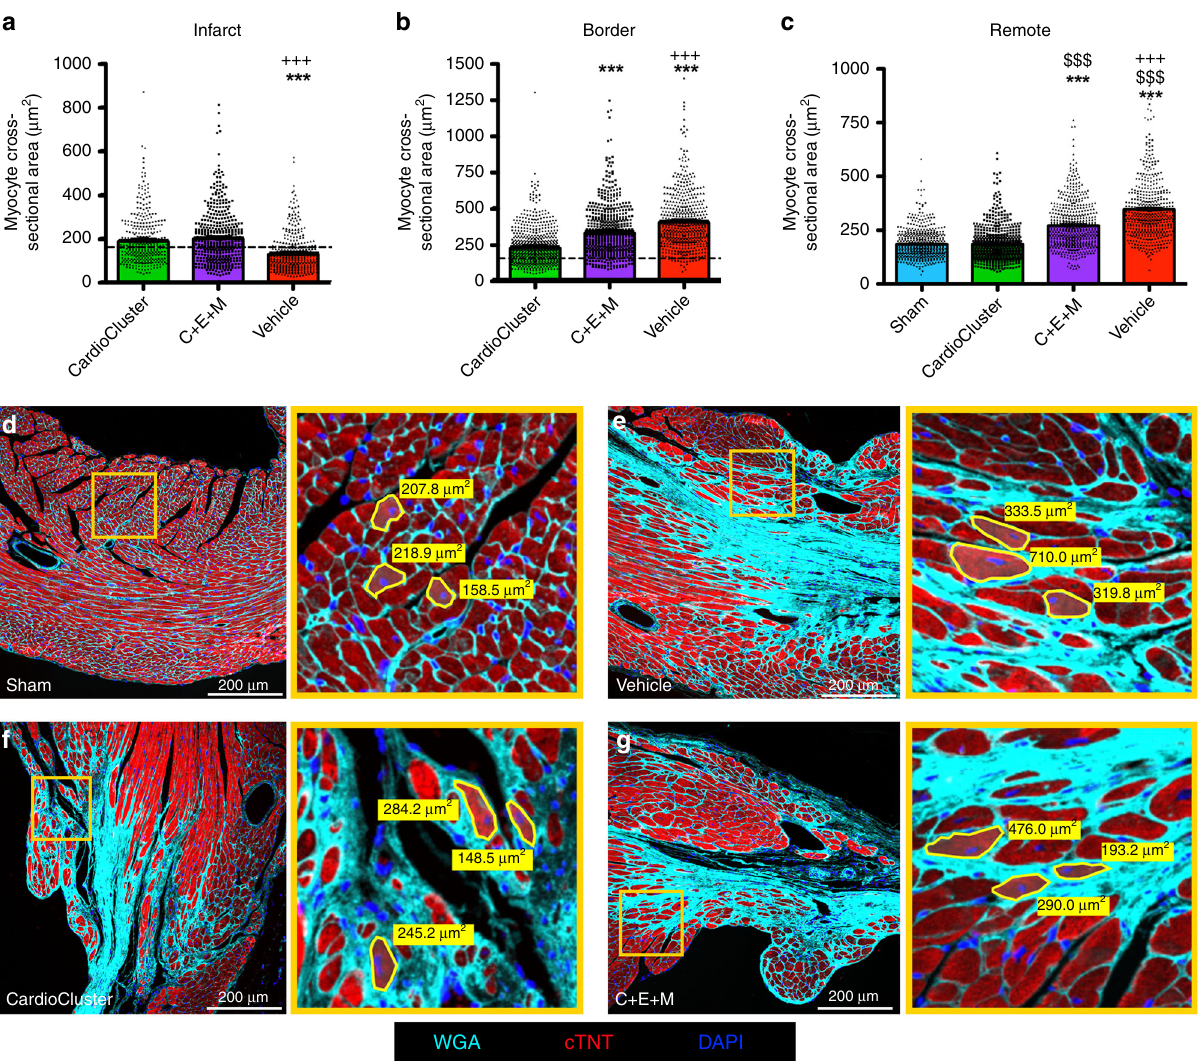
Fig. 8 CardioCluster treatment preserves cardiomyocyte size. a – c Quantitative analysis represents measurement of cross-sectional area of cardiomyocytes from infarct ( a ), border zone ( b ), and remote ( c ) heart regions. Dashed line: mean cross-sectional area of sham group. Data represents mean ( n = 5 CardioCluster-treated mice; n = 5 C + E + M-treated mice; n = 5 vehicle-treated mice; n = 4 sham mice) ± SEM. Data are presented as one-way ANOVA with Tukey ’ s multiple comparison test, *** p < 0.001, versus CardioCluster. +++ p < 0.001, versus C + E + M. $$$ p < 0.001, versus sham. d – g Representative image from sham ( d ) and border zone regions of vehicle ( e ), CardioCluster ( f ), and C + E + M ( g ) used to quantitate cardiomyocyte cross-sectional area (wheat germ agglutinin [WGA]; cyan), cardiac troponin T (cTNT; red), and nuclei (DAPI; blue). Right panels show higher magni fi cation of areas highlighted by yellow boxes. The area of three traced cardiomyocytes per region are shown within magni fi ed view. Scale bars, 200 μ m. Source data are provided as a Source data fi